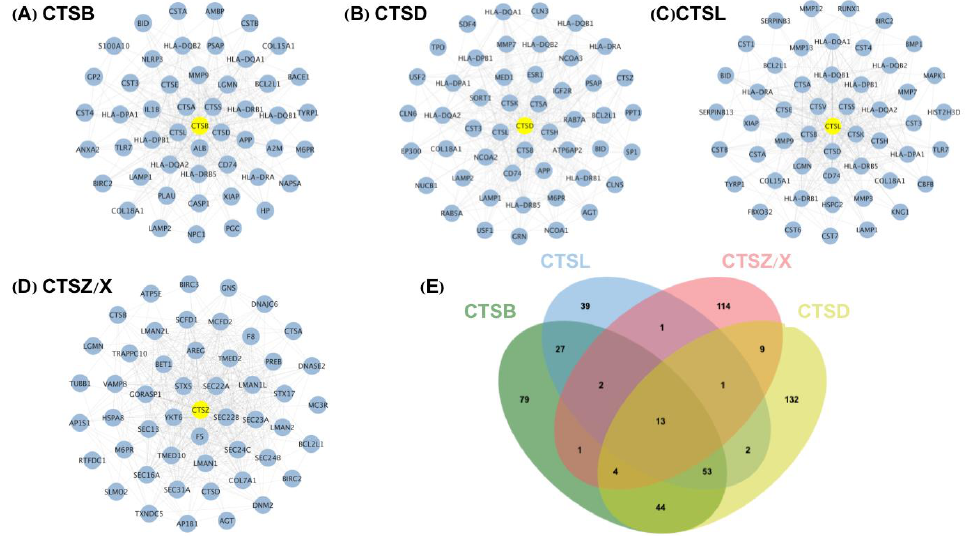
Figure 3. Top 50 PPIs of CTSB (A); CTSD (B); CTSL (C); CTSZ/X (D); Overlapping interacting proteins of four cathepsins (E).